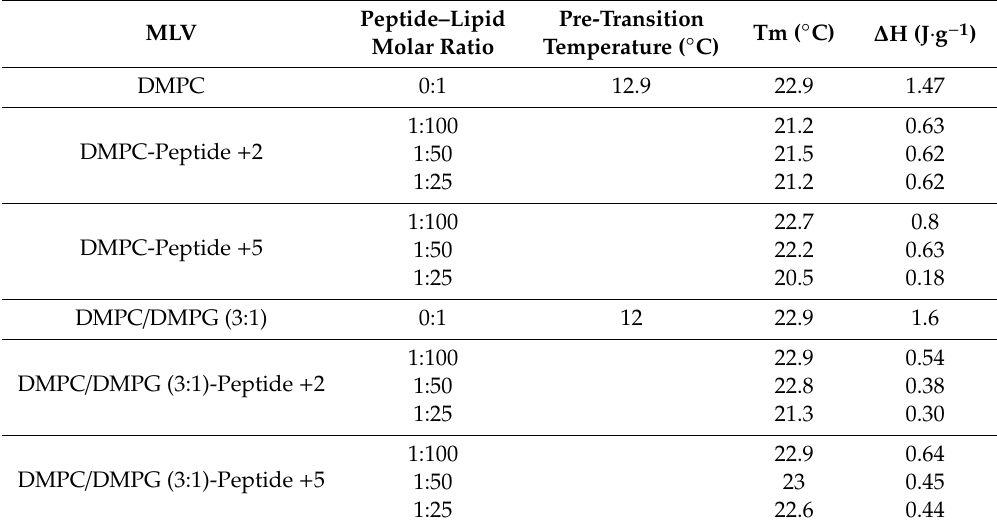
Table 1. Changes in the values of the Tm and Δ H, as result of the interaction of the peptides +2 and +5 at different amounts with MLVs constituted by DMPC and DMPC/1,2-dimyristoyl-sn-glycero-3- phosphoglycerol (DMPG) (3:1). MLV